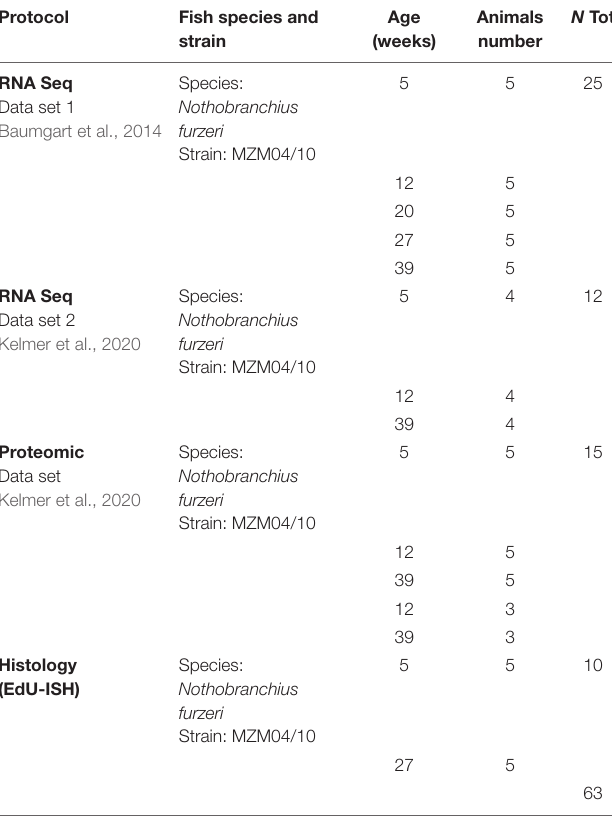
TABLE 1 | Total list of experimental animals used in the study.